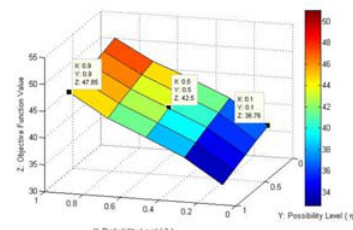
Fig. 6. Necessity optimal solutions for lowest, middle and highest levels of , 